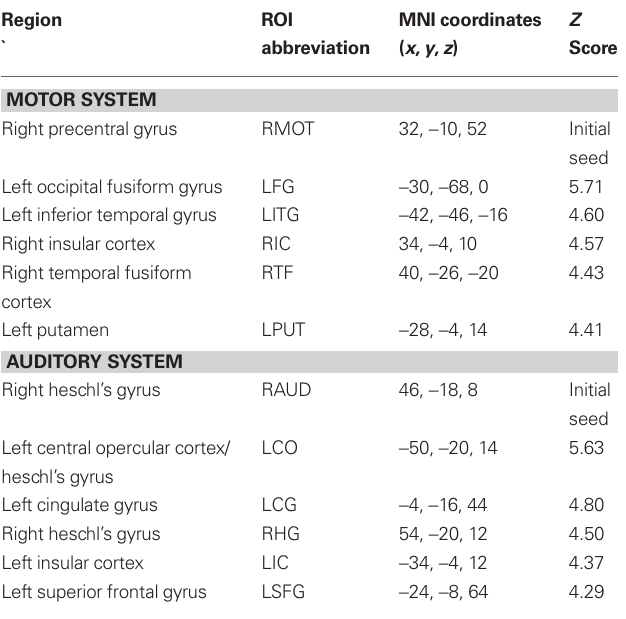
Table 5 | Regions with increased functional connectivity for Young compared to elderly adults in sensorimotor and auditory cortex.